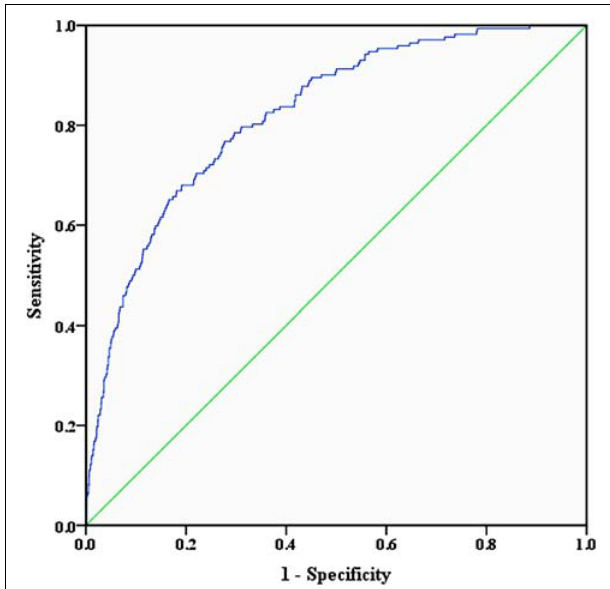
FIGURE 4 | Receiver operating characteristic curve of the nomogram. The sensitivity and specificity of the ROC reflect the discrimination of the nomogram for predicting sleep disorders. The AUC of the nomogram was 0.822 (95%CI: 0.791–0.854) in the validation set. ROC, receiver operating characteristic curve; AUC, area under curve.